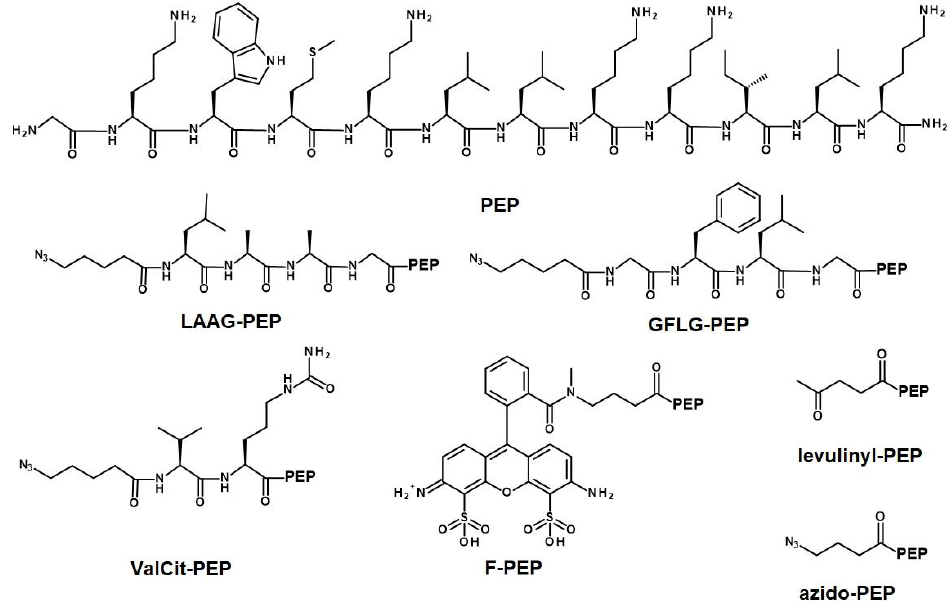
Figure 1. Structures of the antimicrobial peptide PEP and prepared peptide derivatives.